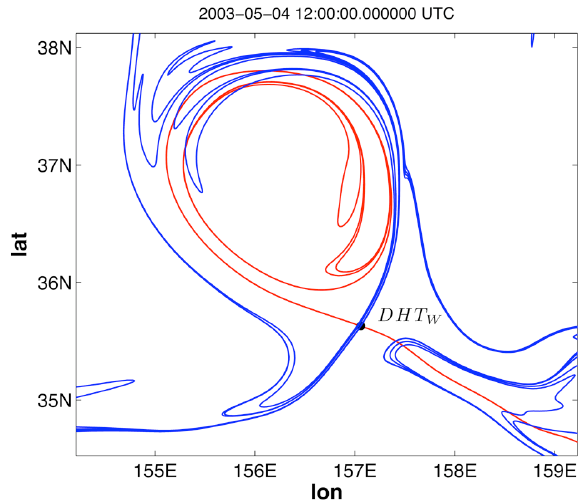
Fig. 16. Stable (blue) and unstable (red) manifolds of DHT W on the 4th of May 2003. (Figure taken from Mendoza et al.,